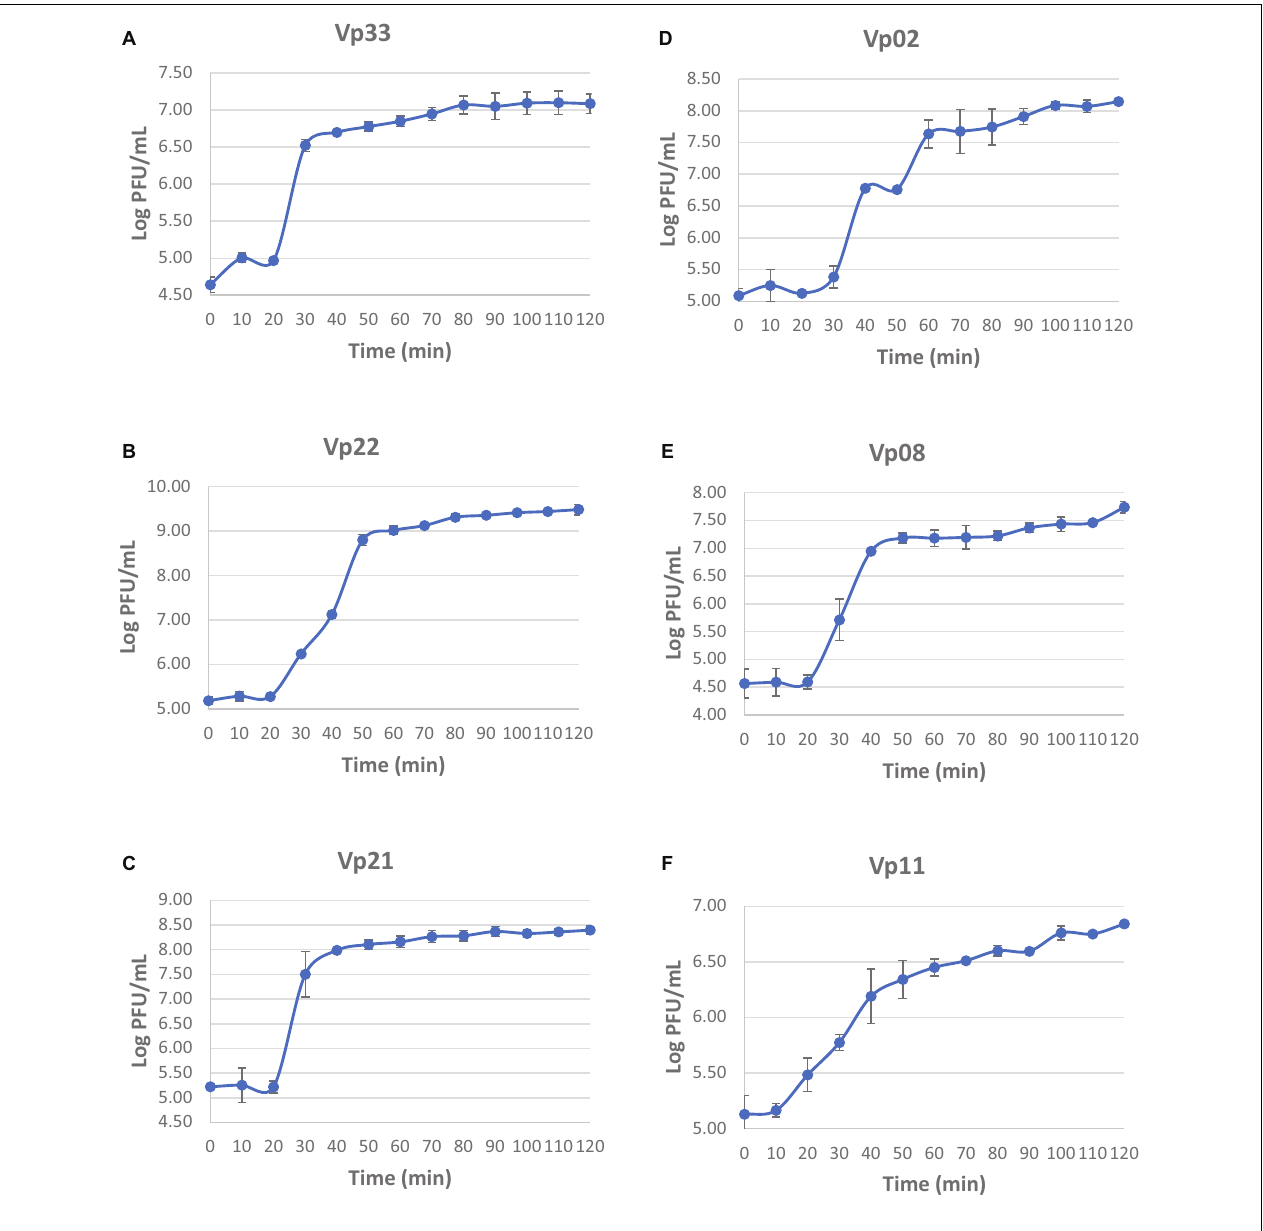
FIGURE 4 | One-step growth curve of bacteriophages. (A) Vp33; (B) Vp22; (C) Vp21; (D) Vp02; (E) Vp08; (F)